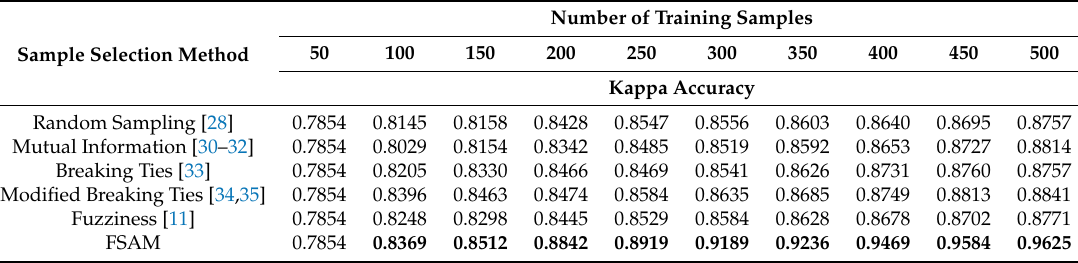
Table 6. Kappa ( κ ) accuracy obtained by KNN Classifier with different number of training samples selected in each iteration from Botswana dataset with different sample selection methods from literature.